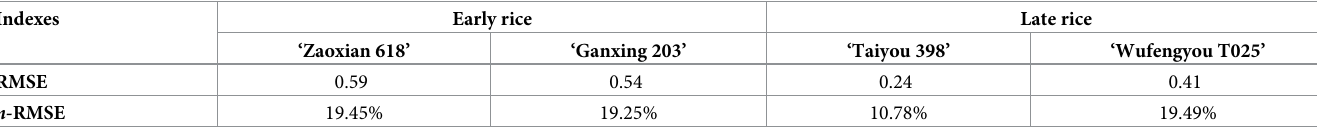
Table 3. Parameter table of the model test